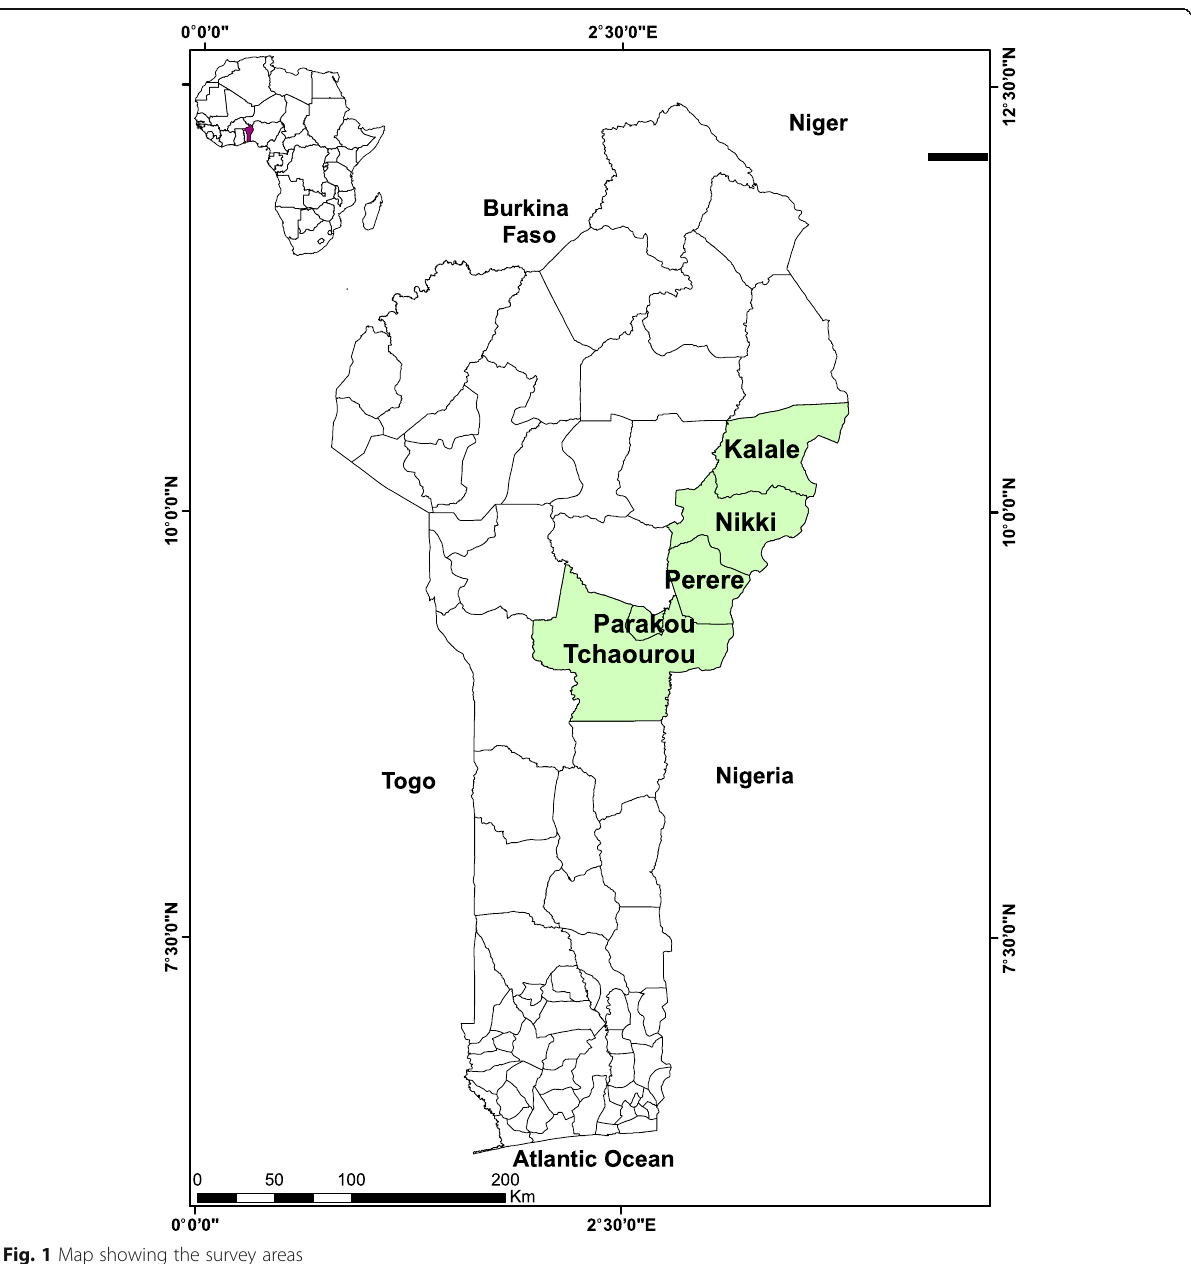
the lack of good breeding bulls (LGBB), the lack of veterinary follow-up (LVF), climate change (CC), labour shortage (LbShort), poor management (PMgm) of the herds, reduction of pasture lands (RedPL), conflicts between farmers and herders and uncontrolled cross-breeding (UCB). These factors were also rated using the Likert 1 to 5 (1 = very low, 2 = low, 3 = medium, 4 = strong, 5 = very strong).